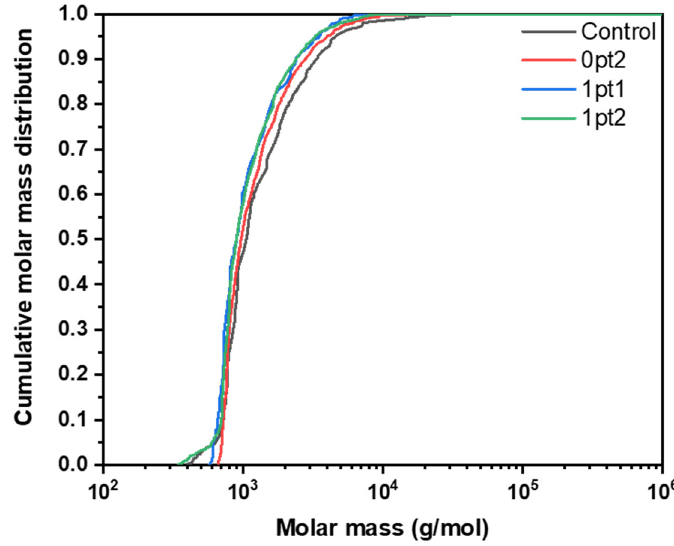
Figure A2. Cumulative molar mass distribution of the extracts from pristine samples.